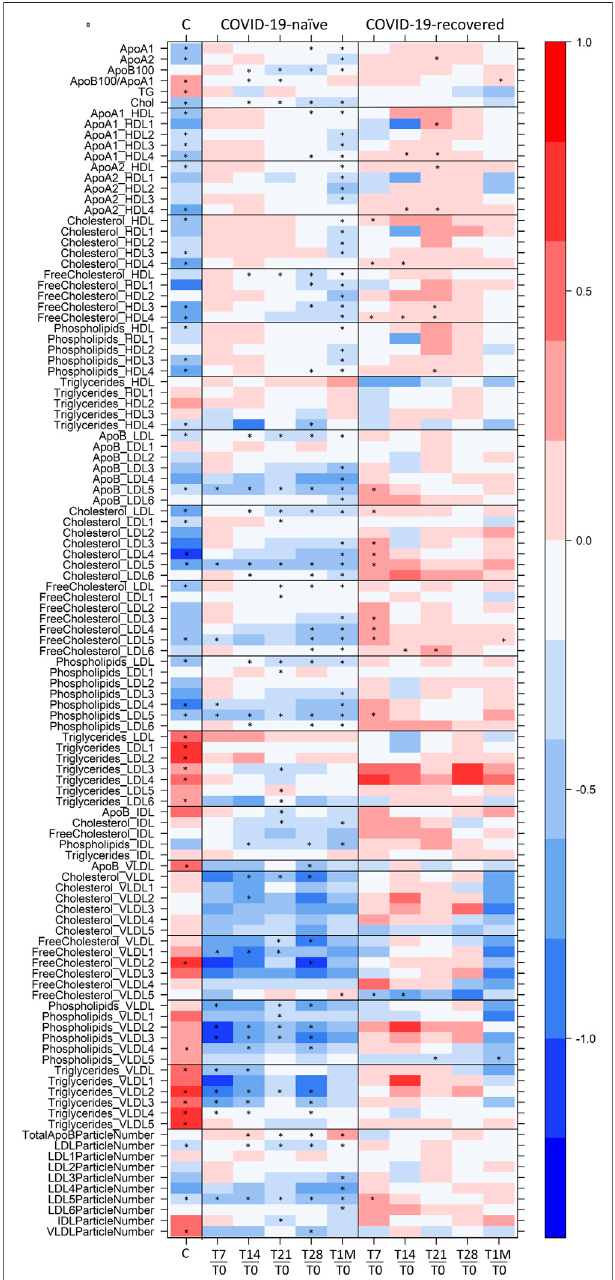
FIGURE 4 | Level plot of Log 2 (FC) of the lipoproteome: for COVID-19- naïve and COVID-19-recovered groups (second and third columns, respectively), red/blue parameters indicate higher/lower concentration at T7, T14,T21,T28,andT1MserumsampleswithrespecttoT0samples.For COVID-19 positive subjects ( fi rst column), red/blue parameters indicate higher/lower concentration in serum samples of 30 COVID-19 patients with respectto30sex-andage-matchedcontrolsubjects(Meonietal.,2021).The brightness of each color corresponds to the magnitude of the FC. Asterisks indicate statistical signi fi cance. The level plot was created using the function levelplot implemented in the R package “ Lattice ” .